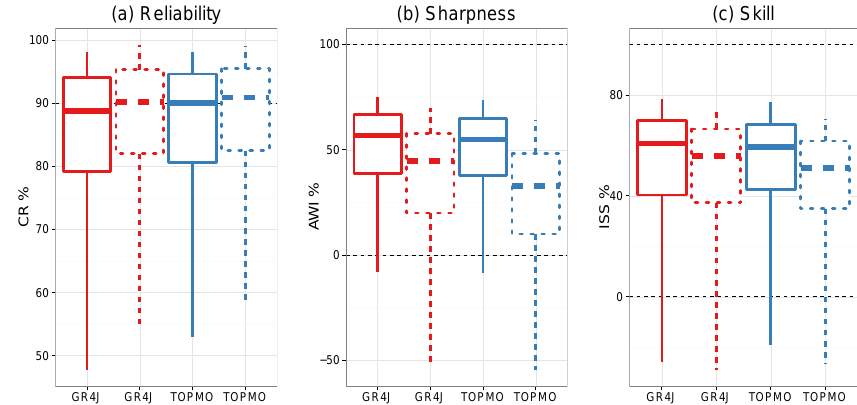
Figure 6. Distributions of the three performance criteria, obtained in two cases: (i) when 10 groups of relative errors are used (solid lines) and (ii) when only one group is used (dashed lines). Boxplots (5th, 25th, 50th, 75th and 95th percentiles) summarise the variety of scores over the 907 catchments of the data set.